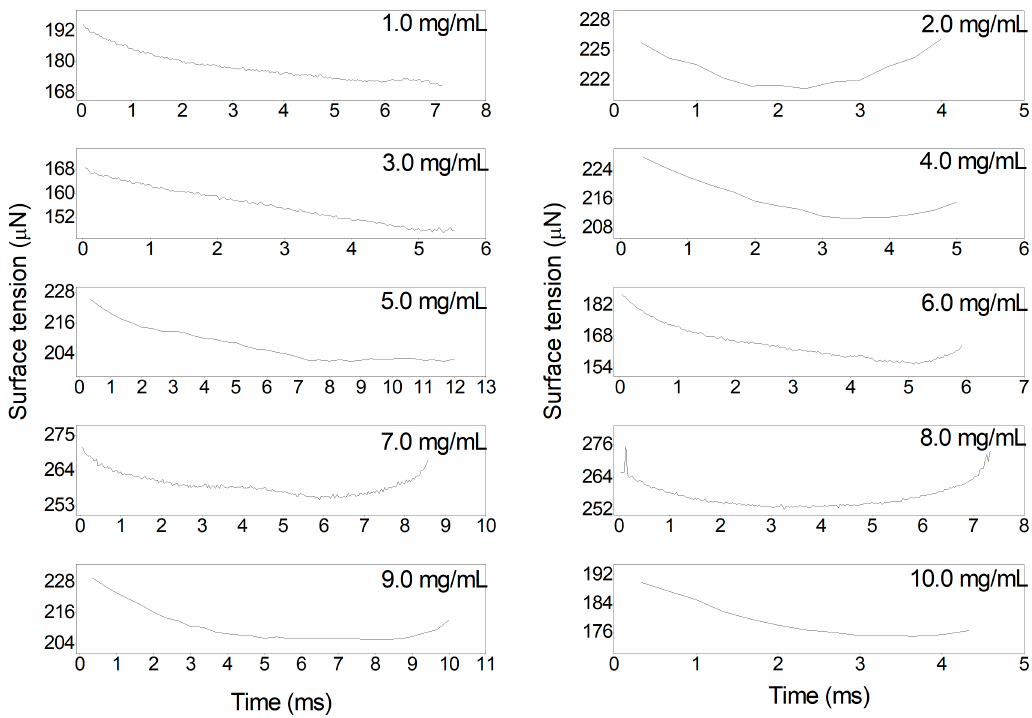
Figure 3. Surface tension during Taylor cone formation.